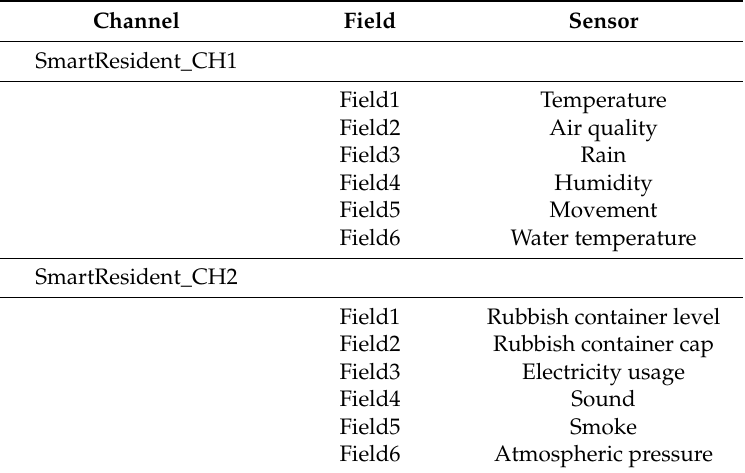
Tabla 2. Channels-fields association in ThingSpeak. Table 2. Channels-fields association in